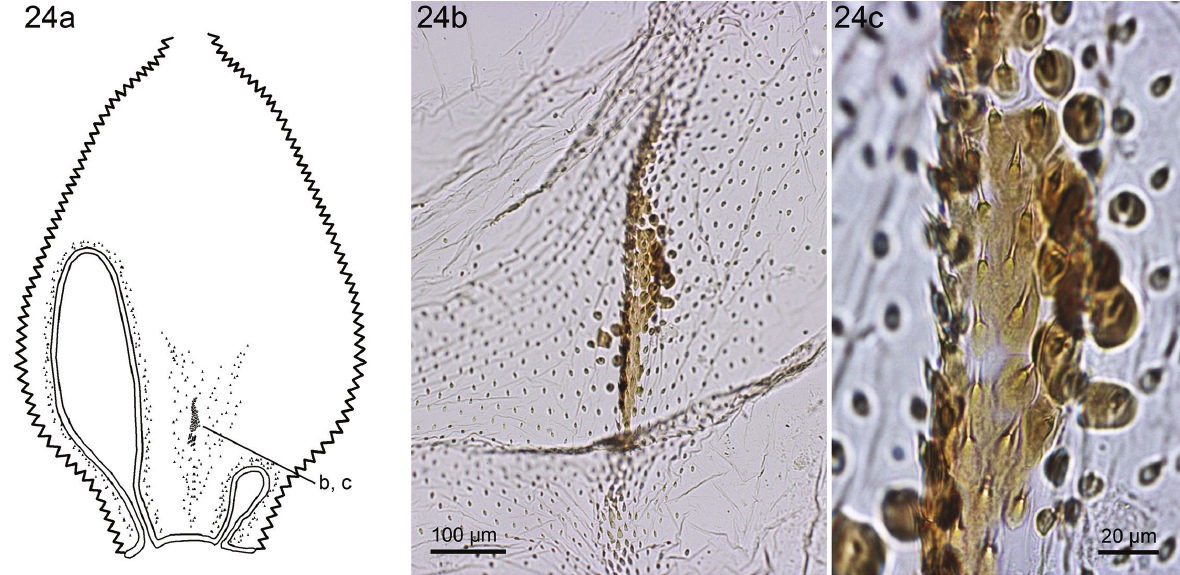
Figure 24. Syntermes spinosus . (a) Schematic drawing of P1 showing arrangement of spines. (b, c) Photomicrographs: (b) General view of sclerotized spines between the mesenteric tongues; (c) Detail of the strongly sclerotized spines with their bases